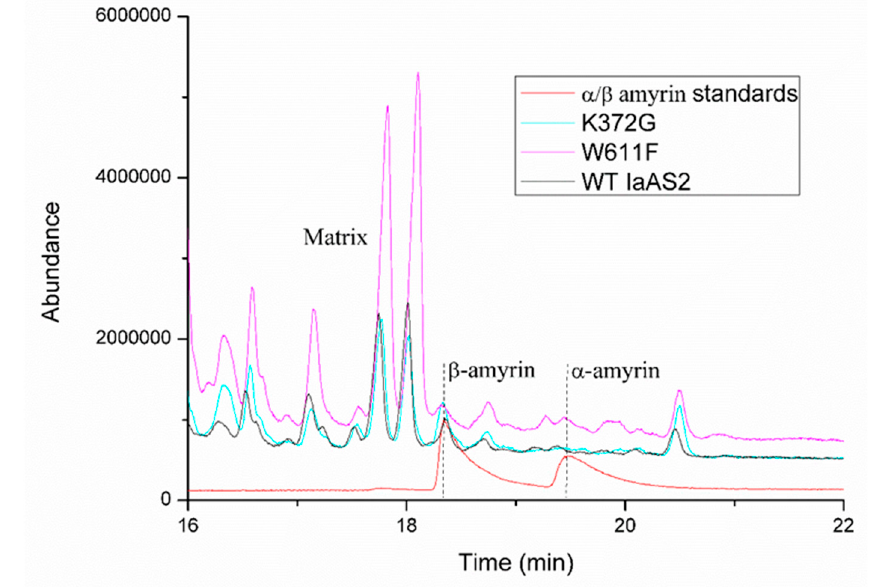
Figure 5. GC analysis of the products of mutated and wild type IaAS2.